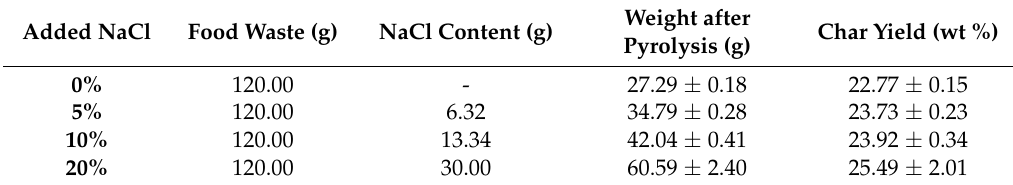
Table 3. Effect of NaCl Concentrations on Food Waste Biochar